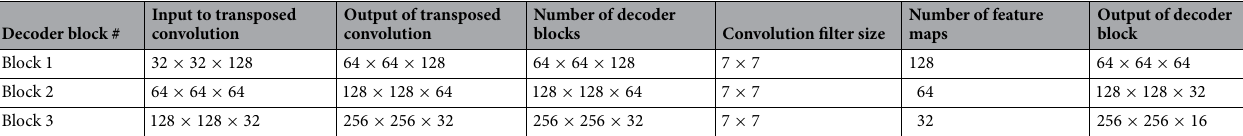
Table 3. Details of all decoder blocks and corresponding transpose convolutional